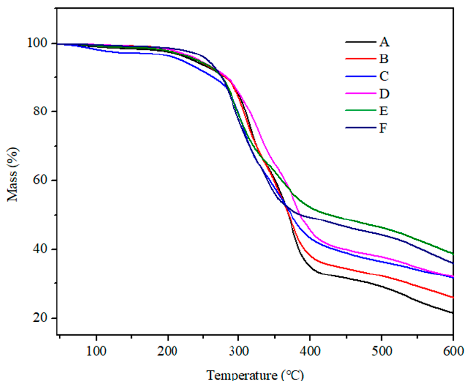
Figure 7. Thermogravimetric curve of HPN-EPPA-UR-PA resin. Table 2. Decomposition temperature and carbon residue of HPN-EPPA-UR-PA